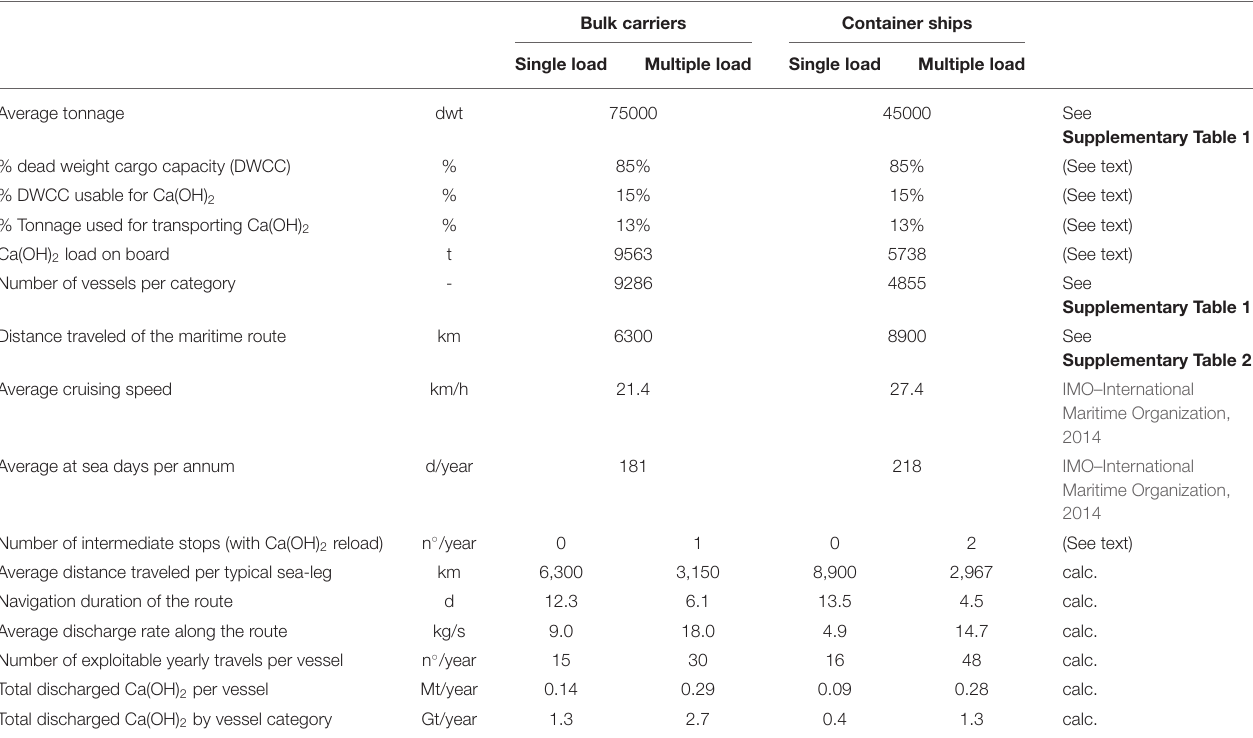
TABLE 6 | Assessment of potential Ca(OH) 2 discharge from bulk carriers and container ships at the global